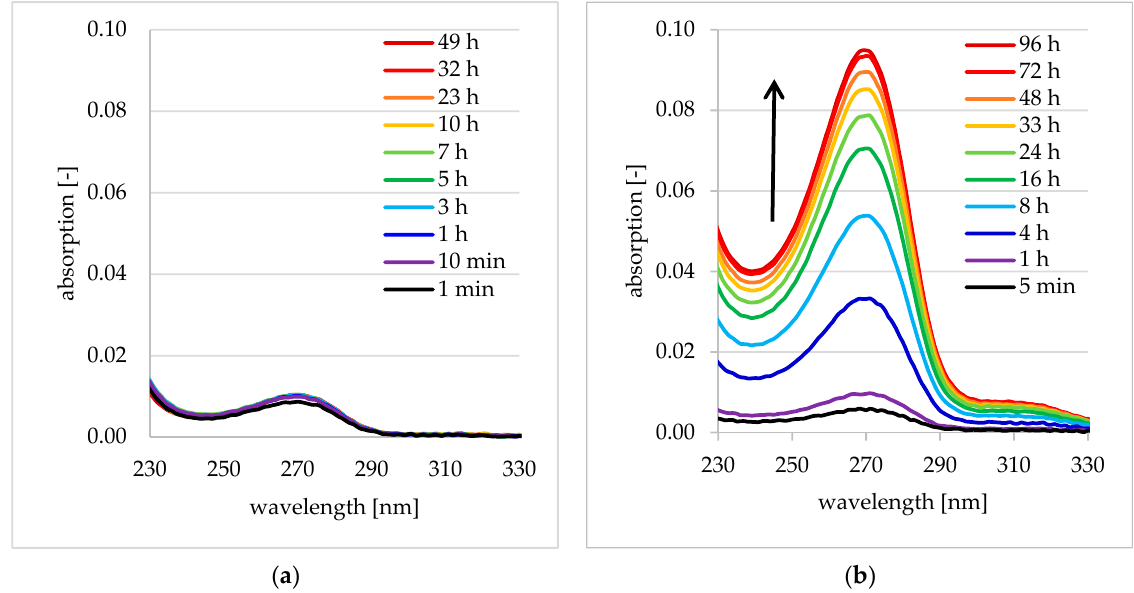
Figure 12. UV/VIS spectra of release media during the release of BZM from ( a ) binary PLL/PLG PEC and ( b ) ternary PDOPAC/PEC coating at Ti40Nb.